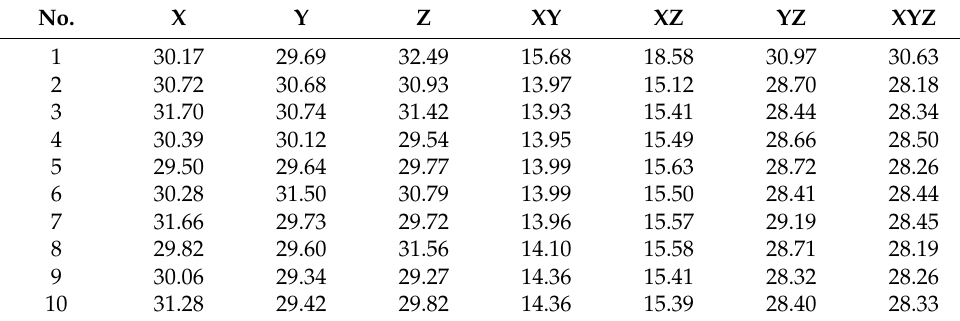
Table 11. CNN summary of ‘training time’ (s).